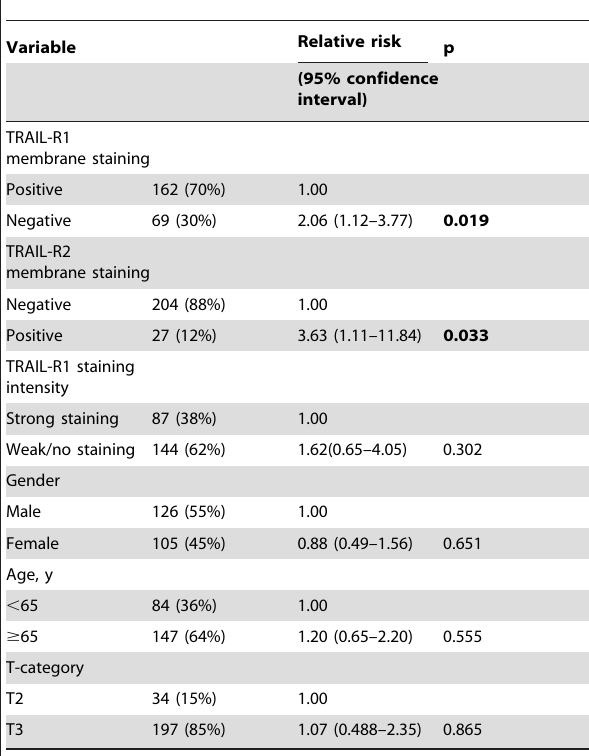
Figure S1 Typical pattern of TRAIL-receptor staining in normal colonic mucosa showing strong (A,C) or weak (B,D) staining for TRAIL-R1 and TRAIL-R2 (Original magnification 630 6 ). Figure S2 Survival plot of patients affected by colorectal cancer acc. to: (A) KRAS status, (B) microsatellite status (MSI =microsatellite instability; MSS= microsatellite stability), (C) amount of KRAS4A splice variant relative to KRAS4B. Censored cases are indicated by a cross. Figure S3 Validation of RT-qPCR based assessment of